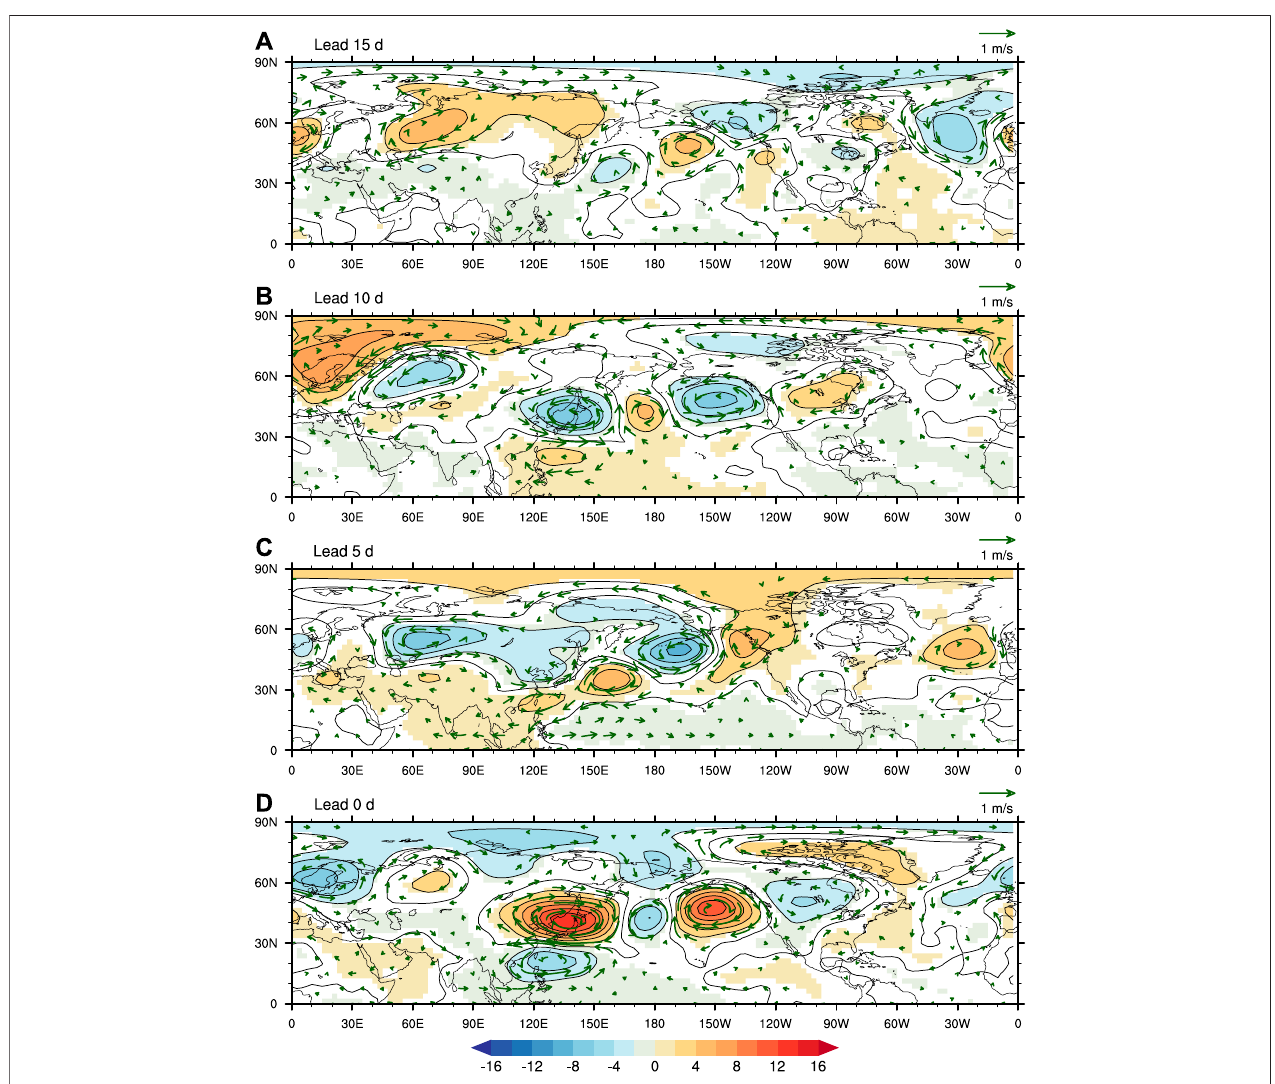
FIGURE 3 | Lead regressions of 10 – 30 days fi ltered Z500 (shaded, unit: gpm) and wind (vectors, unit: m/s) onto WPSH_SMI_10-30d . Shaded areas and vectors represent statistically signi fi cant regressions at 95% con fi dence level based on Students ’ s t tests. The lead n d denotes that Z500 or wind anomaly leads the WPSH_SMI_10-30d by n